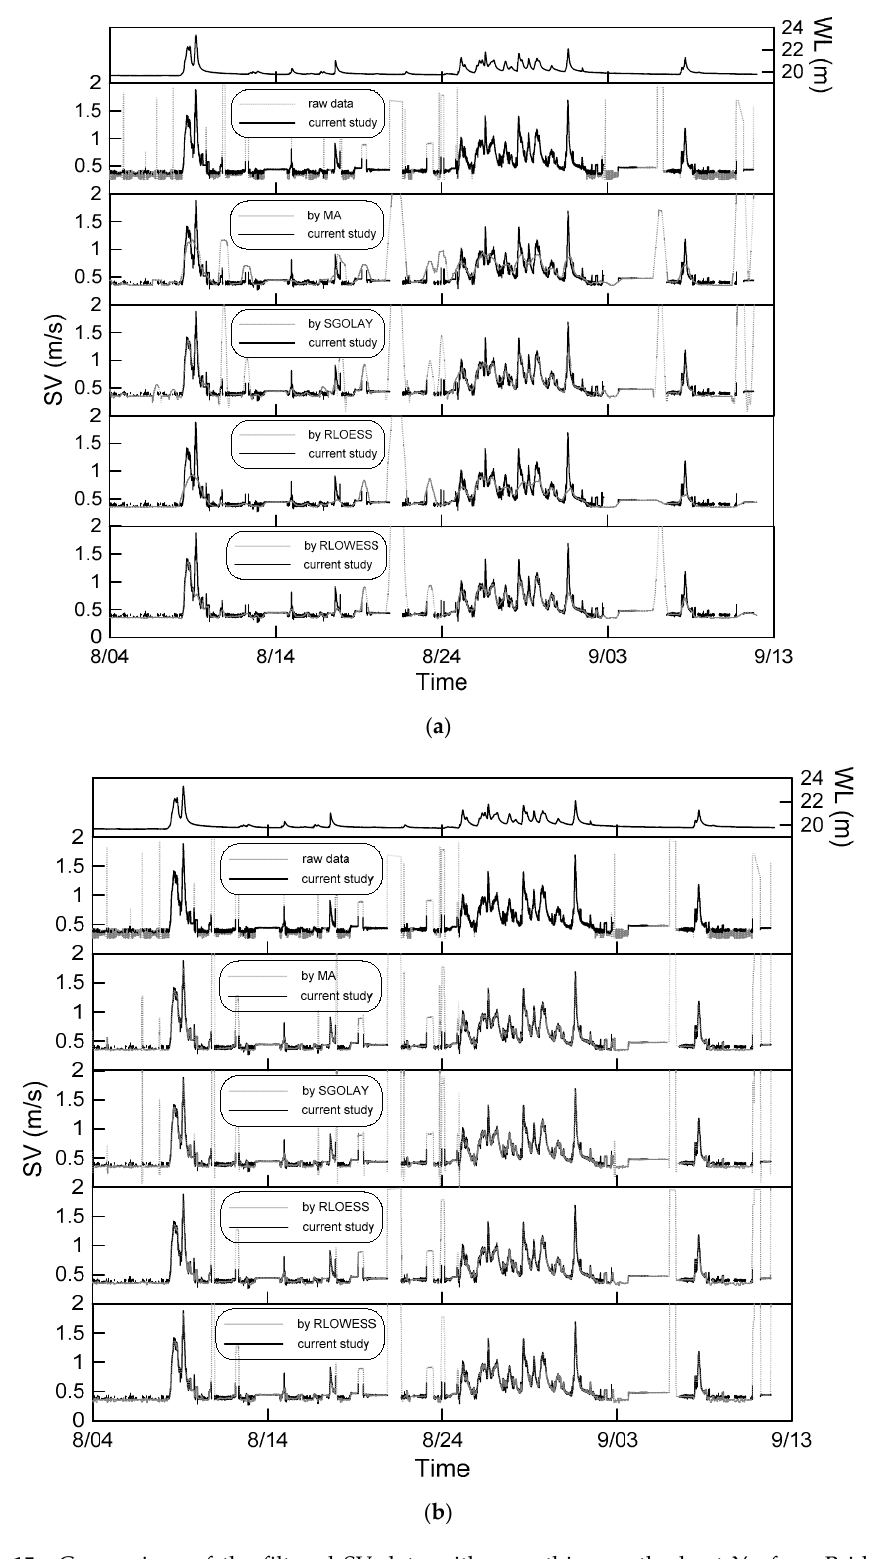
Figure 15. Comparison of the filtered SV data with smoothing methods at Yenfong Bridge: ( a ) bandwidth of 1%; ( b ) bandwidth of 0.1%.